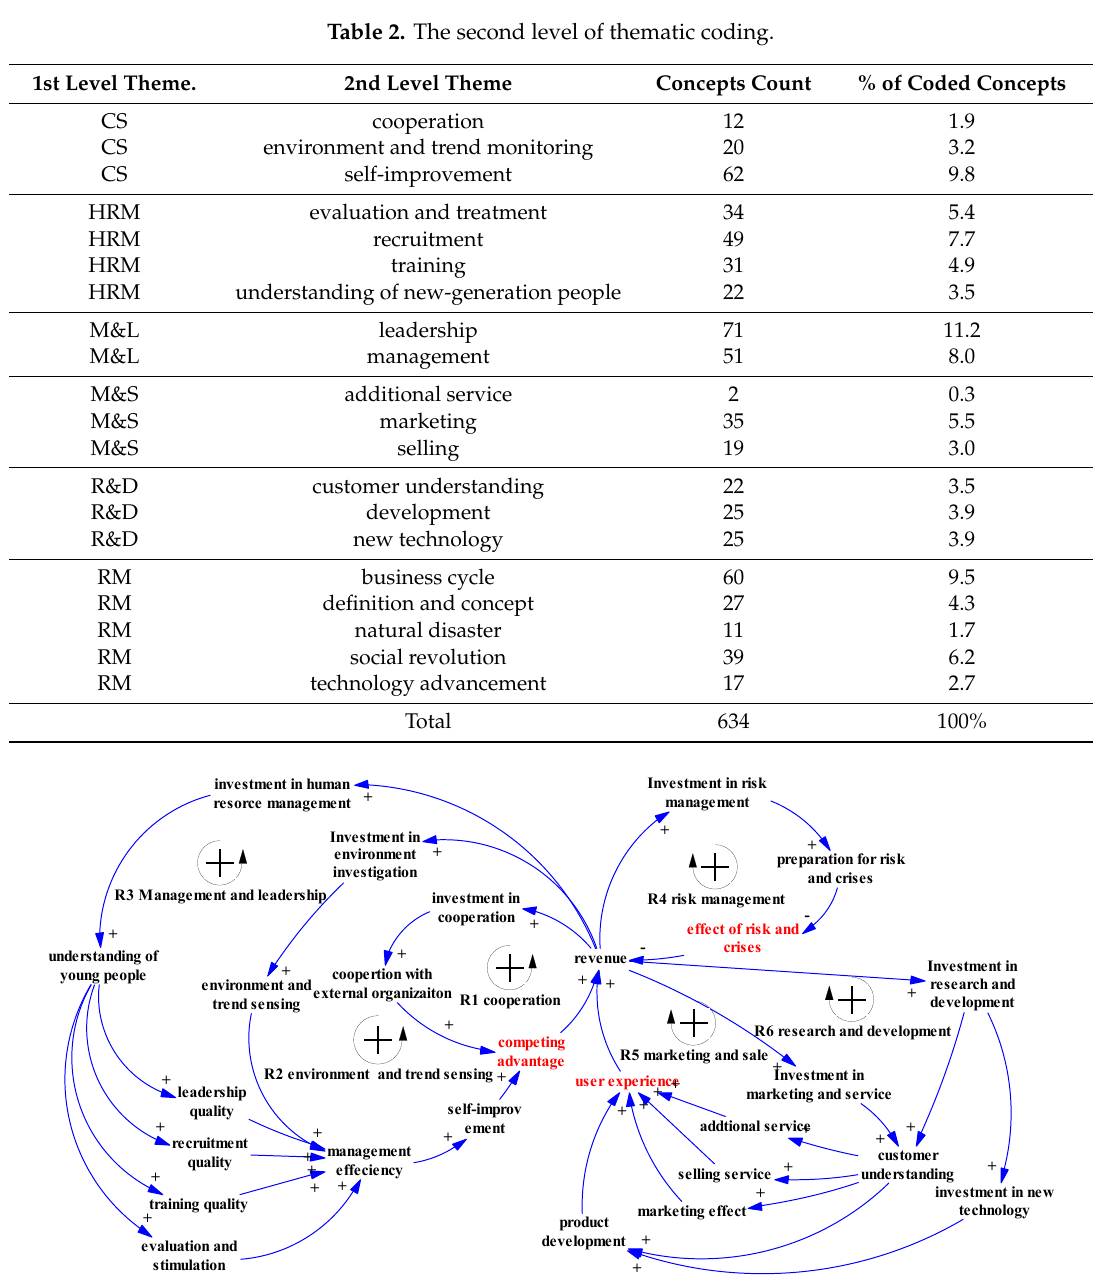
Figure 2. A Causal Loop Diagram of entrepreneurs’ view of entrepreneurship (Part I reinforcing loops).